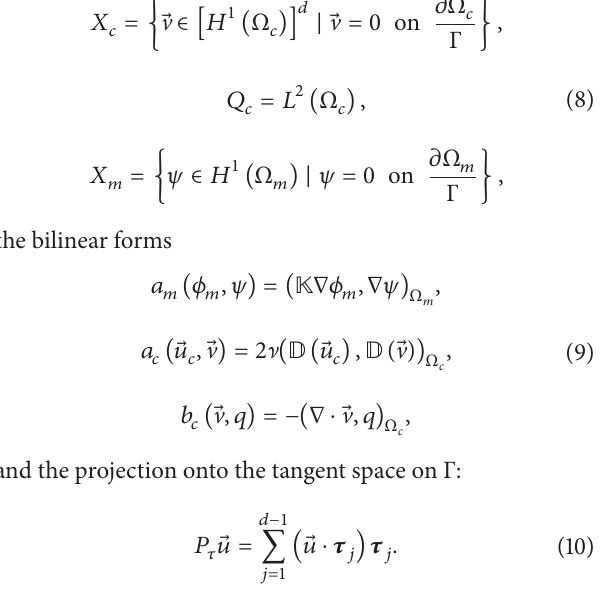
Figure 1: A sketch of the porous median domain Ω 𝑚 , fluid domain Γ Ω 𝑐 , and the interface